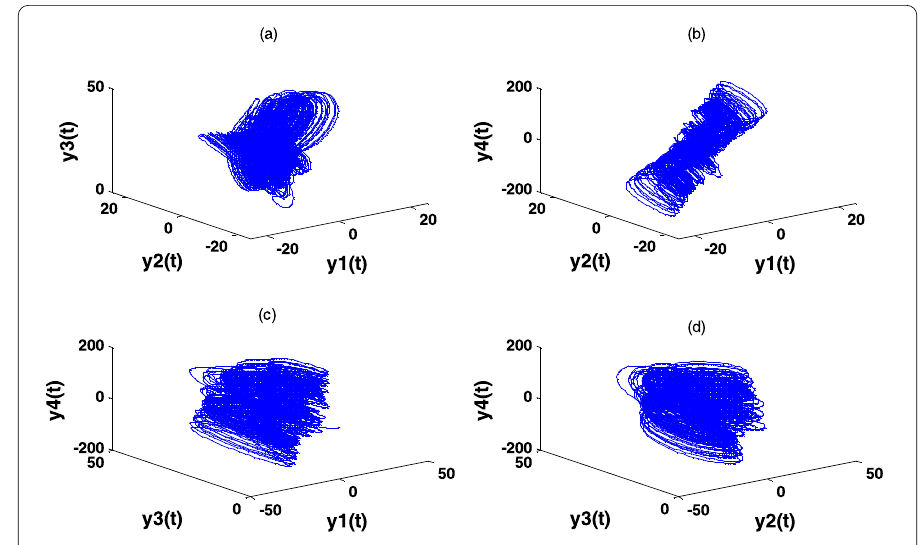
Figure 2 Hyperchaotic attractors of the fractional-order Lorenz system: ( a ) plot in the ( y 1 , y 2 , y 3 )-space; ( b ) plot in the ( y 1 , y 2 , y 4 )-space; ( c ) plot in the ( y 1 , y 3 , y 4 )-space; ( d ) plot in the ( y 2 , y 3 , y 4